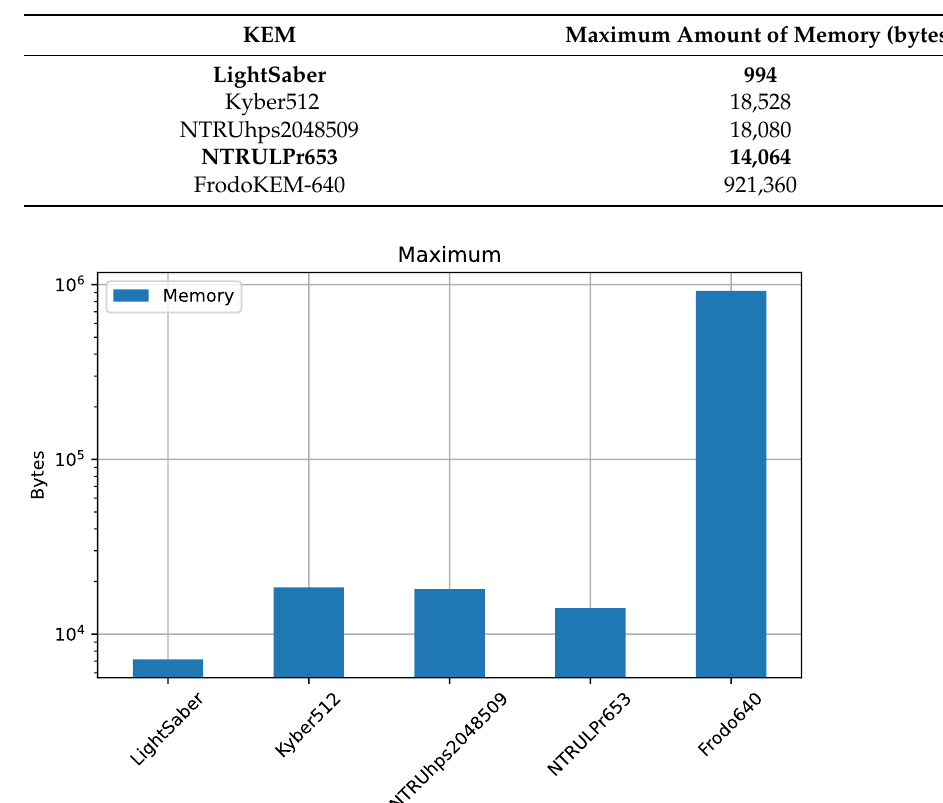
Figure 4. Maximum amount of memory, in bytes, that each KEM uses. We can see again that FrodoKEM640 uses the most, with close to 10 6 bytes. LightSaber uses the least, with less than 10 4 bytes. The other three KEMs use slightly more than 10 4 bytes. The y -axis has logarithmic